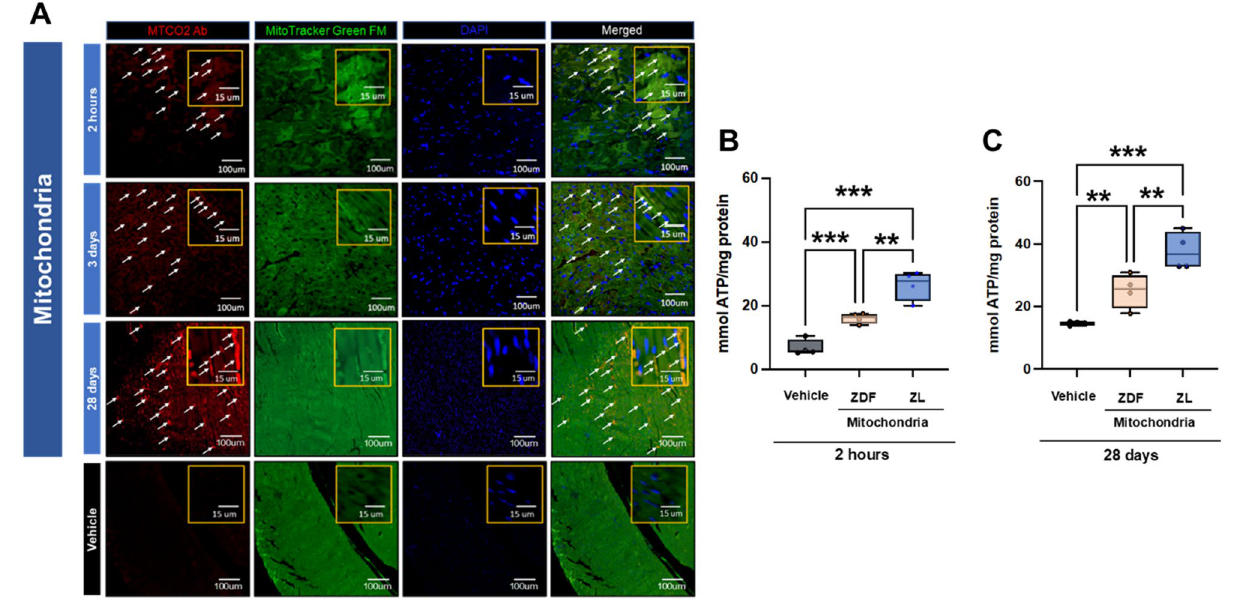
Figure 3. Localization, uptake, and function of transplanted mitochondria. Representative immunofluorescent images ( A ) from ZDF rat hearts following direct injection of vehicle alone (Vehicle) or vehicle containing human mitochondria (Mitochondria) to the hearts of ZDF rats following 30 min of regional ischemia and 2 h, 3 days and 28 days recovery. Human mitochondria were used only to confirm mitochondrial uptake. The use of human mitochondria in a rodent model allows for the differentiation between native rodent mitochondria and transplanted human mitochondria based on immune reactivity to a monoclonal anti-human mitochondria antibody (MTC02). Human mitochondria are shown labelled with human mitochondrial MTCO2 antibody (MTCO2ab, red). Mito-Tracker Green FM was used to show the injected mitochondria and in situ mitochondria. Nuclei were stained using DAPI (blue). Merged images are shown on the far right. Images are shown enlarged and with specific areas for each image enlarged to show detail. Enlarged images are boxed in gold. Transplanted human mitochondria are indicated by arrows. Mitochondria were observed within and around cardiomyocytes. Scale bars are 15 um and 100 um in length. Total tissue ATP content in the area-at-risk mmol/mg protein in vehicle hearts and in hearts receiving diabetic ZDF or non-diabetic ZL-mitochondria at 2 h ( B ) and 28 days ( C ) recovery. All results are shown as the mean plus and minus the standard error of the mean for n = 6 for each group. Statistical differences are shown as * p < 0.05, ** p < 0.01, *** p <